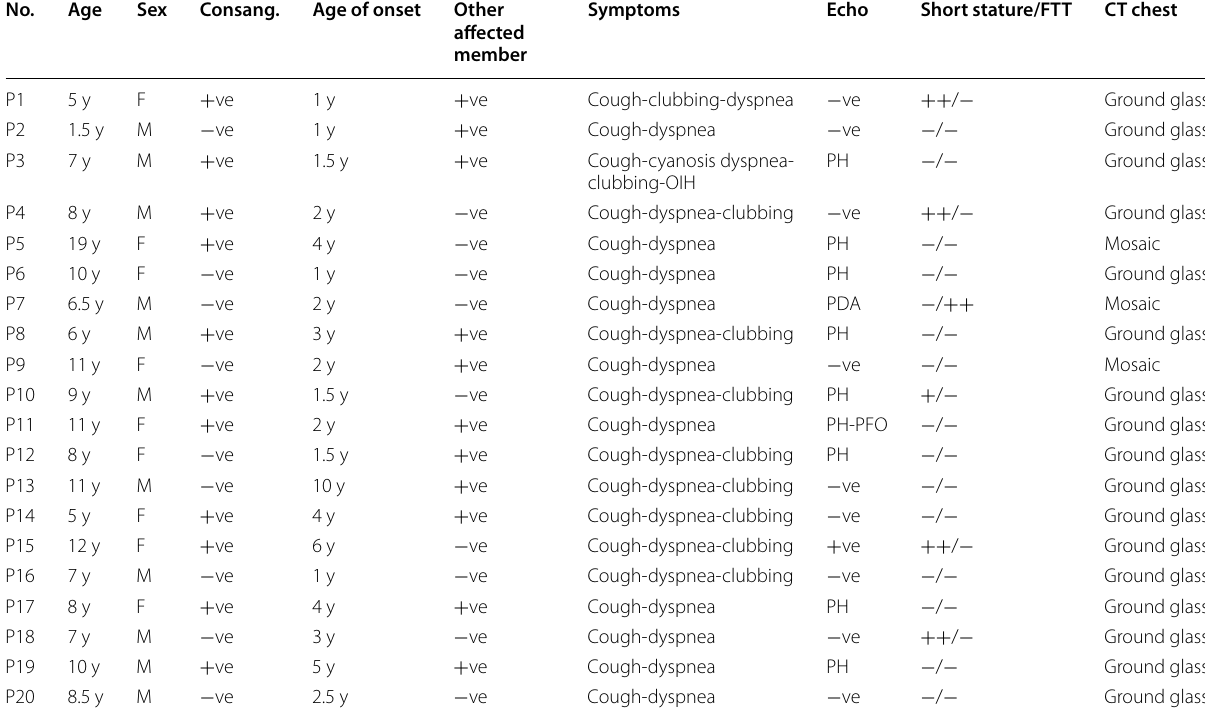
PH pulmonary hypertension, PDA patent ductus arteriosus, PFO patent foramen oval, FTT failure to thrive